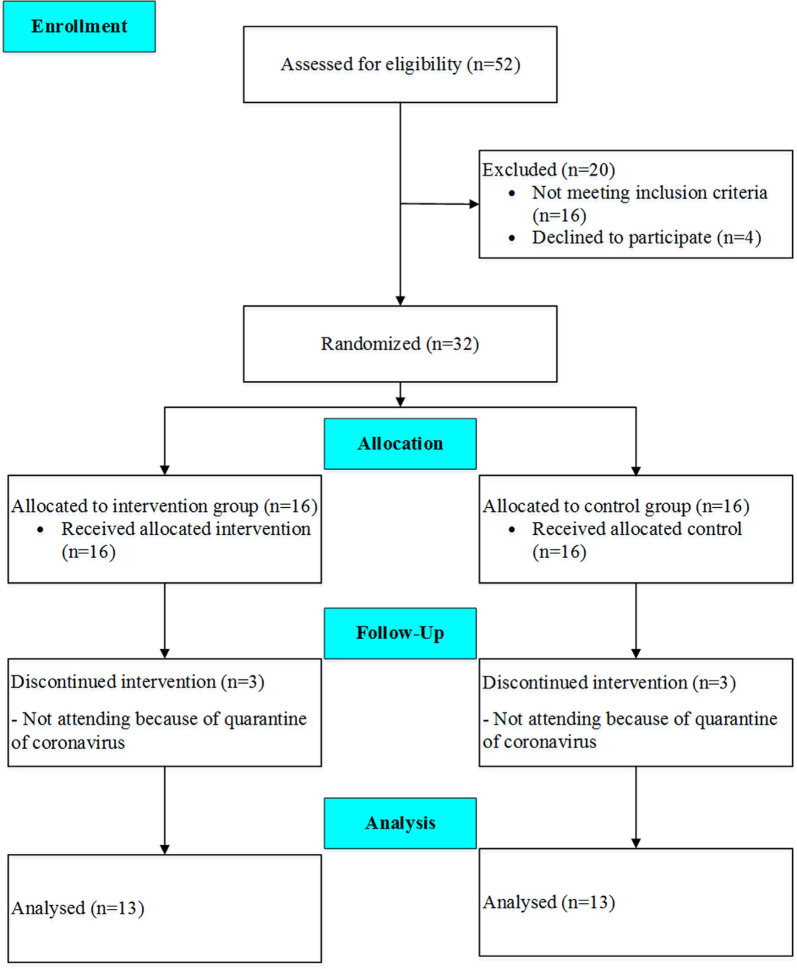
CONSORT flow diagram of the study.